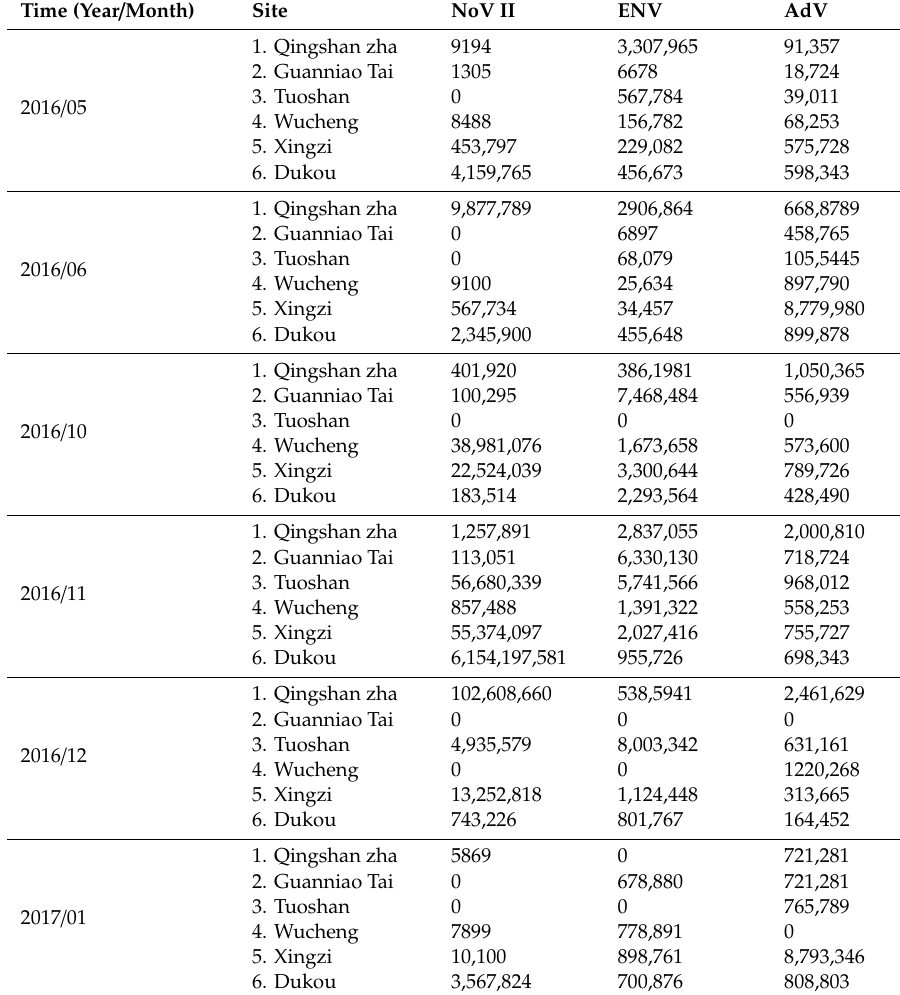
Table 7. Detection of enteric viruses among di ff erent seasons and sampling site through Tianjin’s method quantitative PCR (GC / L) a .